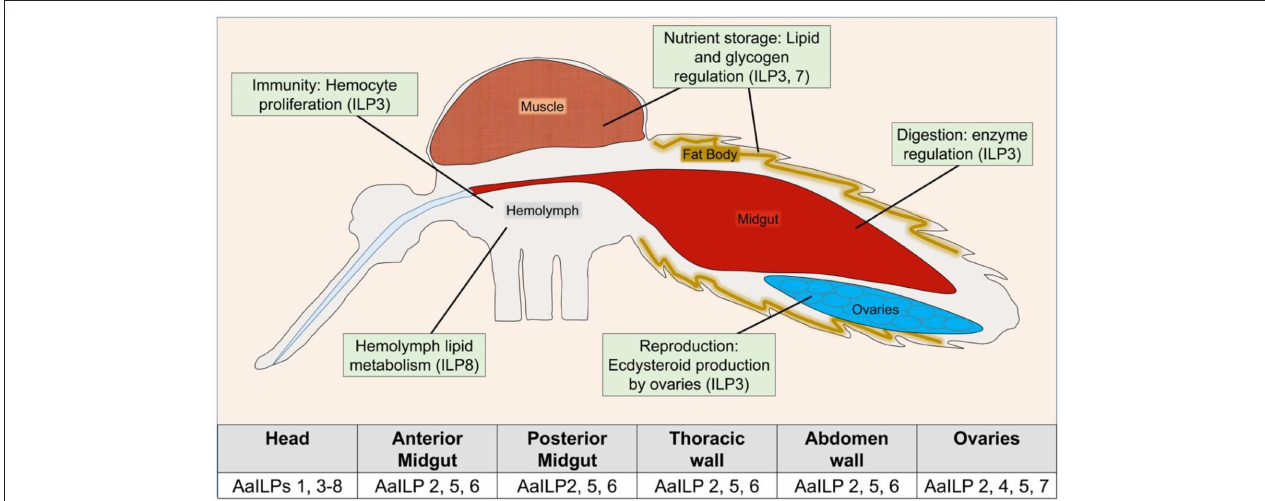
FIGURE 3 | Overview of known ILP functions in Ae. aegypti . Table indicates detection of AaILP expression in adult females, as summarized from (5). For a more detailed description of ILP functions in other species, see Table 2